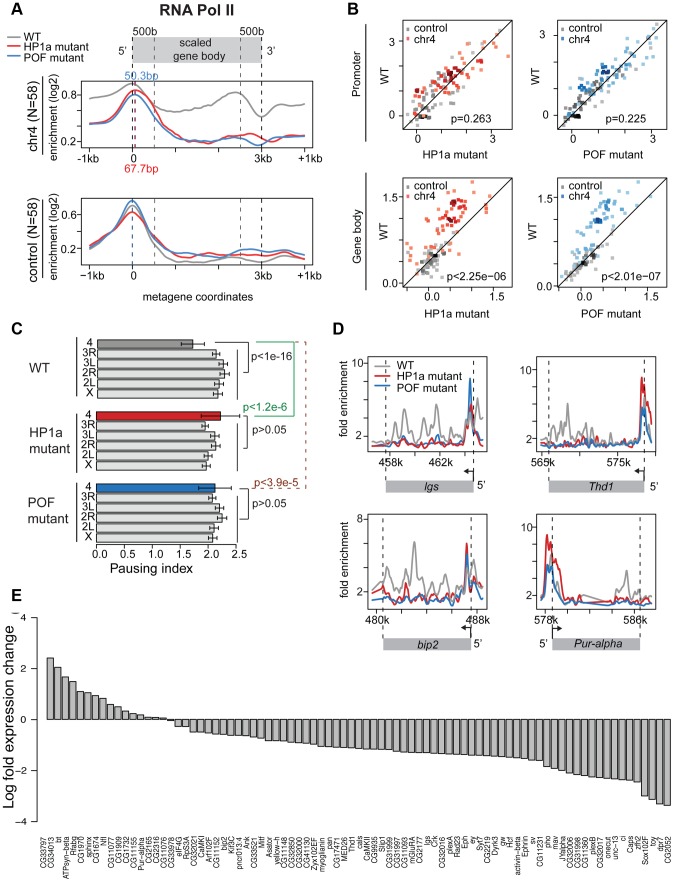
Lack of HP1a or POF shifts the enrichment pattern of RNA pol II on chromosome 4.A. RNA pol II distribution of expressed genes on chromosome 4, comparing wildtype (WT) to HP1a (red) and POF (blue) mutants. Chromosome 4 genes are compared to genes with similar expression levels randomly chosen from the euchromatin on chromosome arm 3R (N = 58 for both). Note the dramatic loss of RNA pol II enrichment in the gene body of the mutants for chromosome 4 genes, but not for the control euchromatic genes. The TSS-proximal RNA pol II peak also changes in the mutants compared to wildtype, moving approximately 68 bp and 50 bp downstream, respectively. B. Scatter plot showing enrichment of RNA pol II at the promoter region (+/−500 bp of TSS, top panel) and gene body (bottom panel). In both HP1a and POF mutants, the RNA pol II enrichment decreases significantly only in the gene body. C. Pausing index (PI) changes specifically on chromosome 4 in HP1a and POF mutants. In both mutants, PI for chromosome 4 genes increases to a range similar to the other chromosomes. D. Examples of the shift of RNA pol II in four chromosome 4 gene regions in the mutants. In Pur-alpha, no probes were available from 581 kb–584 kb. E. Fold changes of expression level (FPKM) of chromosome 4 genes in the HP1a mutant compared to the wildtype. Data from third instar larvae.